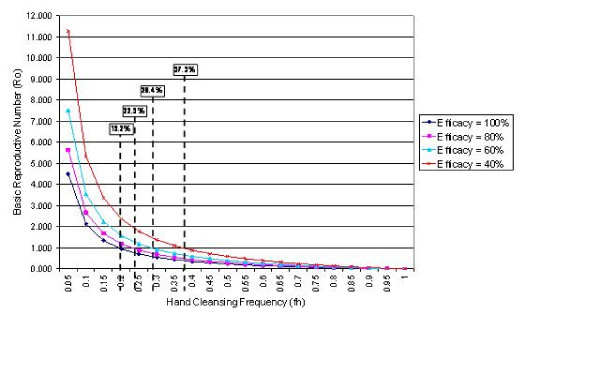
The relationship between the basic reproductive number, R0, and hand cleansing frequency, fh, for a range of hand cleansing efficacies (i.e. λ' = 100%, 80%, 60% and 40%). The broken lines represent to hand cleansing frequencies which equate to R0 = 1. Transmissibility is assumed to be 0.1.